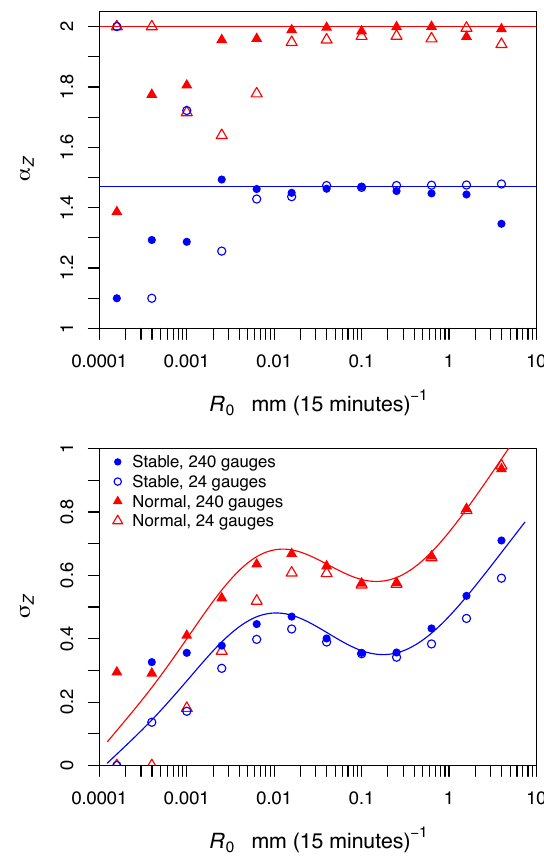
Fig. 11. Stable distribution parameters α Z and σ Z for Z = ln Y + against large-scale areal-averaged rainfall rates R 0 for R 0 > 0 as es- timated from simulated rainfall using the rainfall-dependent mod- els SI σ /RD σ /LS (log-stable) and SI σ /RD σ /LN (log-normal). The blue and red horizontal lines show the assumed values of α Z (up- per panel) and σ Z (lower panel) for models SI σ /RD σ /ST and SI σ /RD σ /LN, respectively. The solid symbols show the parame- ter values estimated using 240 “gauges”, represented by 240 grid cells in finest resolution field (approximately 15cm × 15cm). The open symbols show the parameter values estimated using 24 such